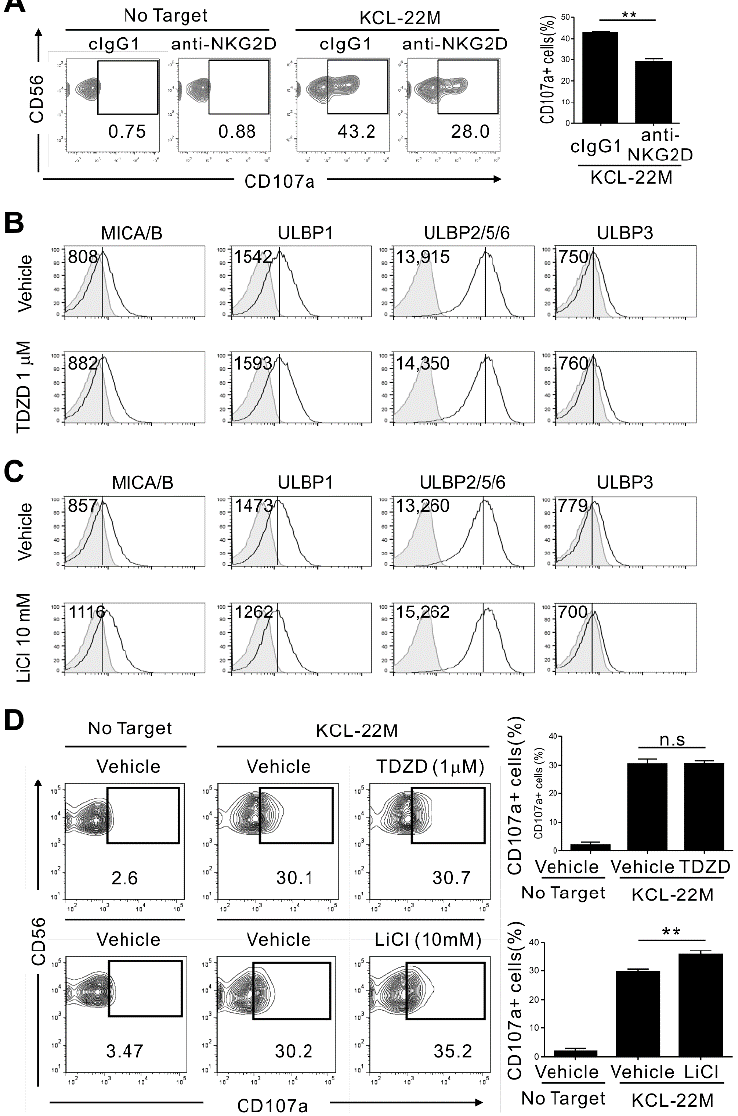
Figure 1. Inhibition of GSK-3 enhances NKG2DL expression and NK cell-mediated cytotoxicity against KCL-22M cells. ( A ) KCL-22M cells were pretreated with IM (5 μ M) for 48 h, washed, and then mixed with expanded primary NK cells preincubated with a monoclonal Ab to the NKG2D receptor (20 μ g/mL) for 2 h. Degranulation of NK cells was measured by the surface expression of CD107a on CD3 - CD56 + NK cells. Representative flow cytometry profile (left) and summary graph (right) demonstrating the percentage of CD107a + NK cells. ( B , C ) The surface expression of NKG2DL (MICA/B, ULBP1, ULBP2/5/6, and ULBP3) was analyzed by flow cytometry on KCL- 22M cells treated with the GSK-3 inhibitor TDZD-8 (1 μ M; GSK-3 β -selective) ( B ) or LiCl (10 mM;